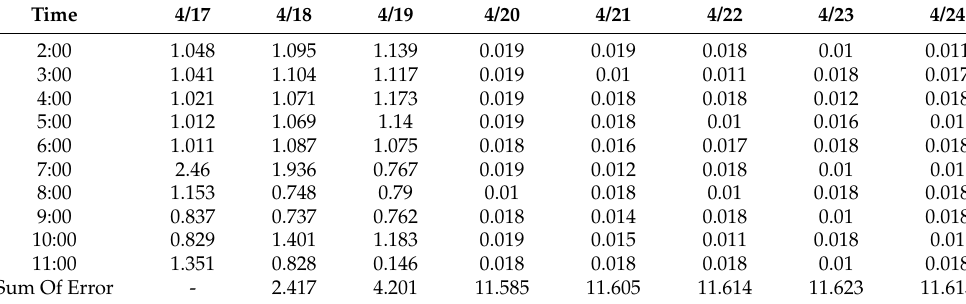
Table 3. Euclidean similarity